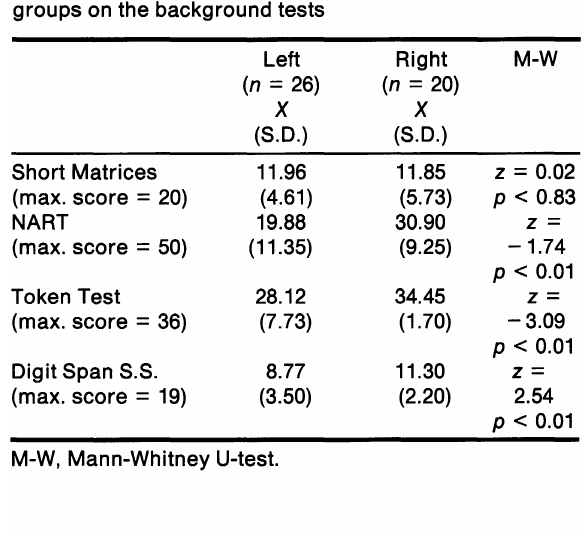
-Abscess, cyst, undiagnosed.